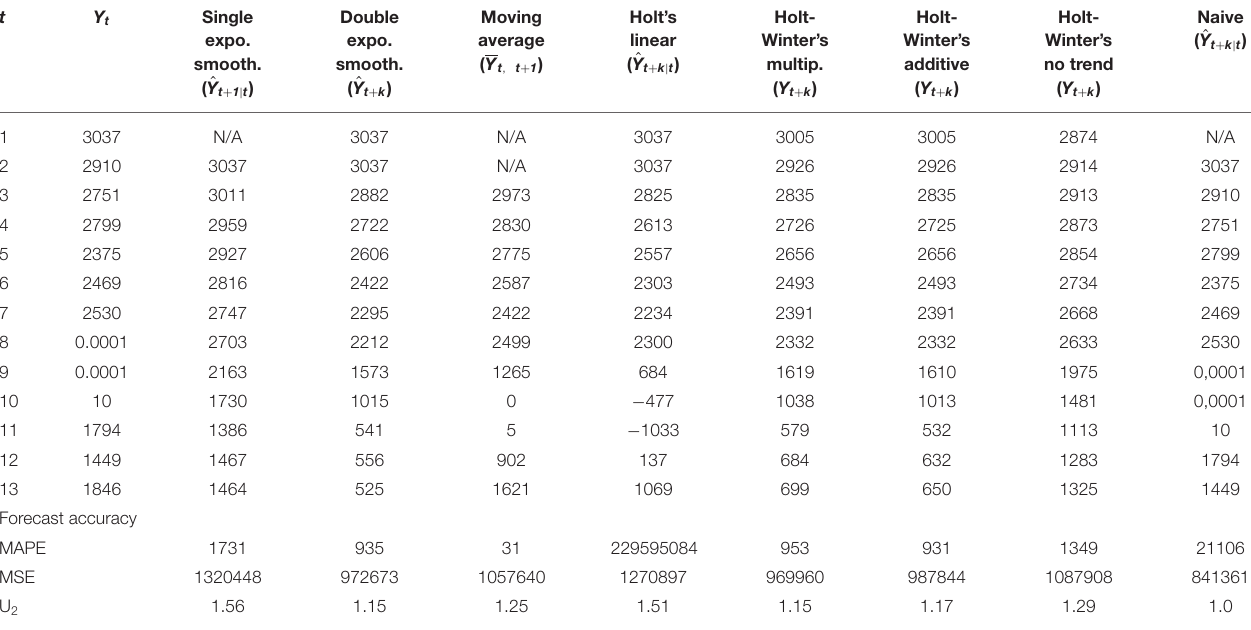
TABLE 8 | The results of forecasting (first approach and product with